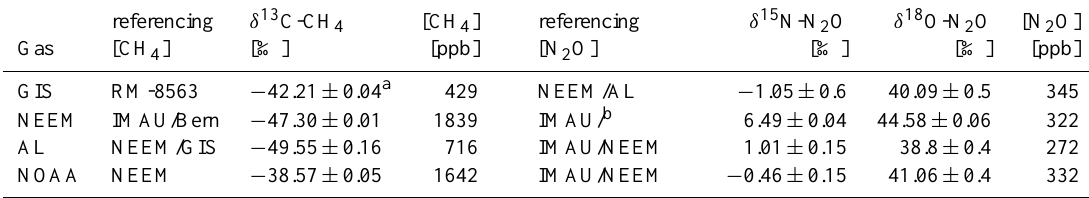
Table 1. Applied gases. Reference gas names are listed in column 1. Column 2, 3 and 4 show the calibration path for δ 13 C-CH 4 , the determined δ 13 C and the mixing ratio of CH 4 , respectively. The referencing path for N 2 O is mentioned in column 5, while column 6, 7, and 8 indicate the δ 15 N, the δ 18 O and the mixing ratio of N 2 O, respectively. The standard deviation for the isotopic composition of N 2 O in GIS is larger compared to the other gases due to the calibration with two gases during measurements that were optimized to measure δ 13 C-CH 4 . The larger scatter results from the measurement of small N 2 O amounts. Note that the mean value of the QCS measurements for the isotopic composition of N 2 O proves very good accuracy for the calibration of GIS (Fig.